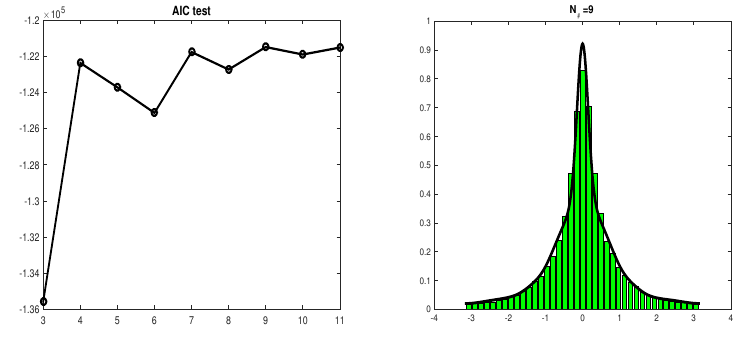
Figure 5. Left, AIC test for the Gamma test. Right, fit with N Θ = 9 basis functions. As an example from a real world problem we report the result of